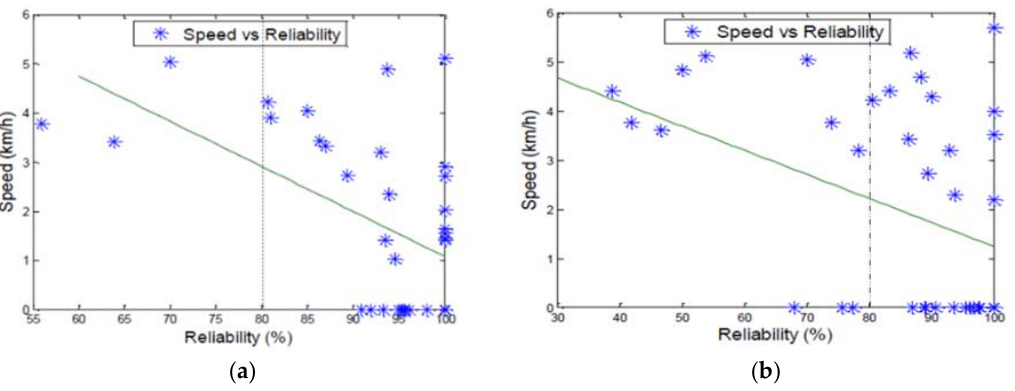
Figure 17. These figures depict the relationship between the speed and the reliability. ( a ) Speed vs. reliability 8 bytes. ( b ) Speed vs. reliability 16 bytes.